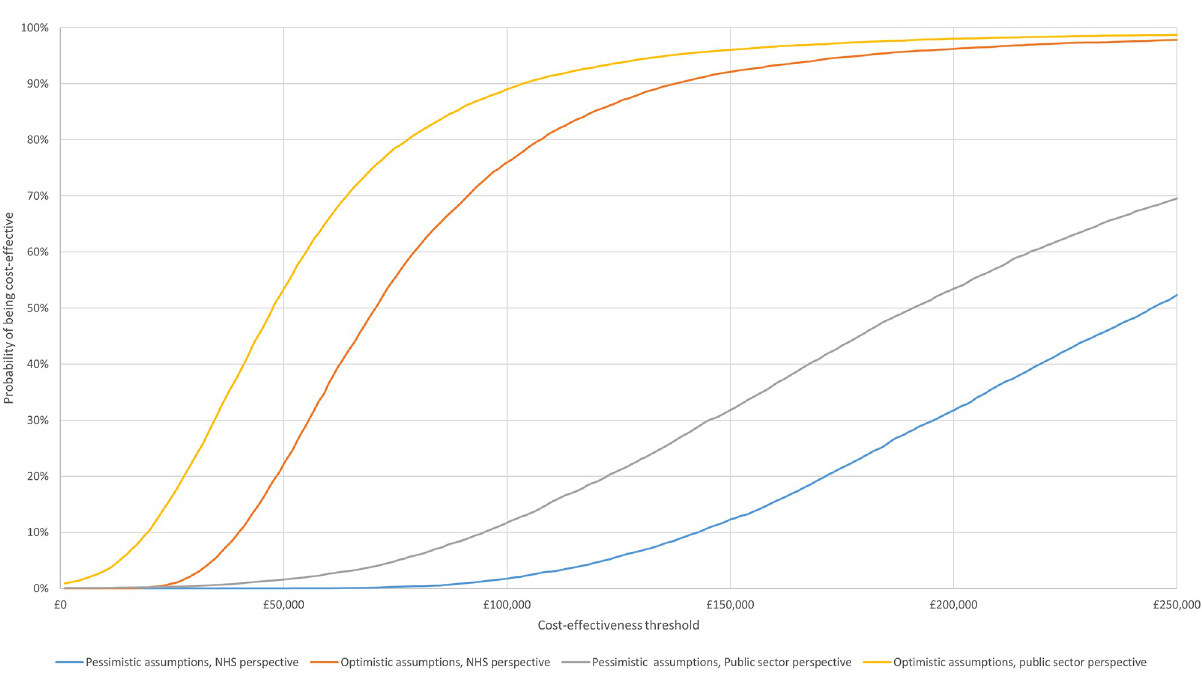
Fig 4. Cost-effectiveness acceptability curve